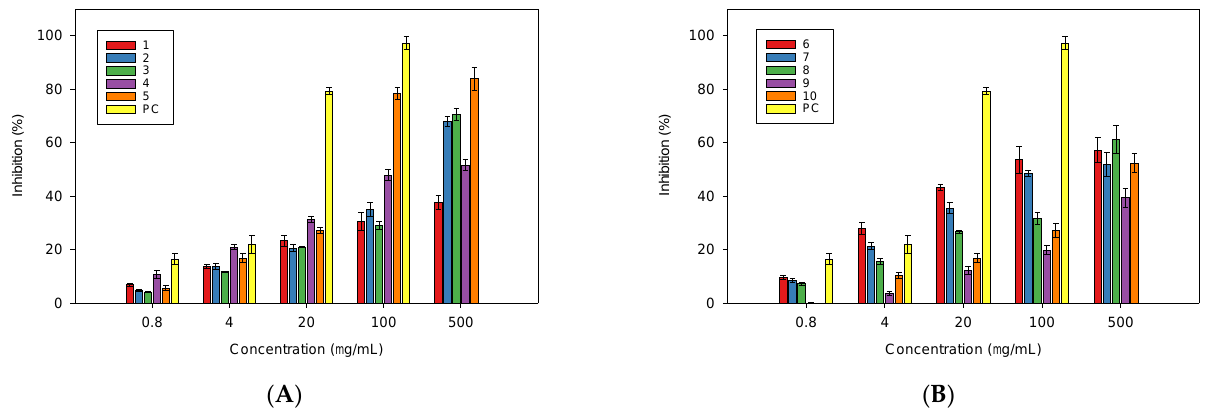
Figure 2. NO production inhibition of the isolated compounds from Millettia speciosa . Compounds — ( A ): ( 1 : friedelin; 2 : rotundic acid; 3 : pedunculoside; 4 : uvaol; 5 : ursolic acid); ( B ): ( 6 : gypenoside XVII; 7 : pterocarpin; 8 : syringin; 9 : daidzin; 10 : rutin). The test compounds were evaluated for their inhibition at a concentration range of 0.8 – 500 µg/mL. PC: positive control treated with L-NMMA at a concentration range of 0.8 – 100 µg/mL.